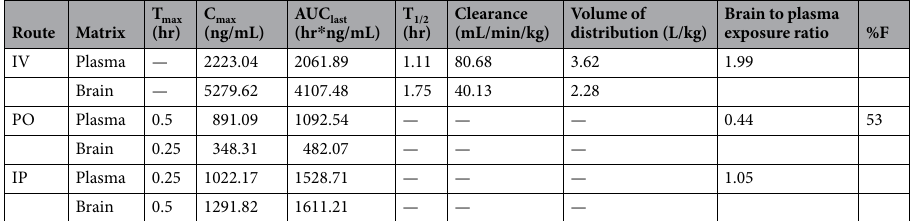
Table 1. Pharmacokinetic parameters of NPT200-11 in plasma and brain following a single 10 mg/kg intravenous, intraperitoneal or oral administration in male C57BL/6 mice. Notes: 1 AUC last considered for calculating bioavailability. 2 The density of brain homogenate was considered as 1 which is equivalent to plasma